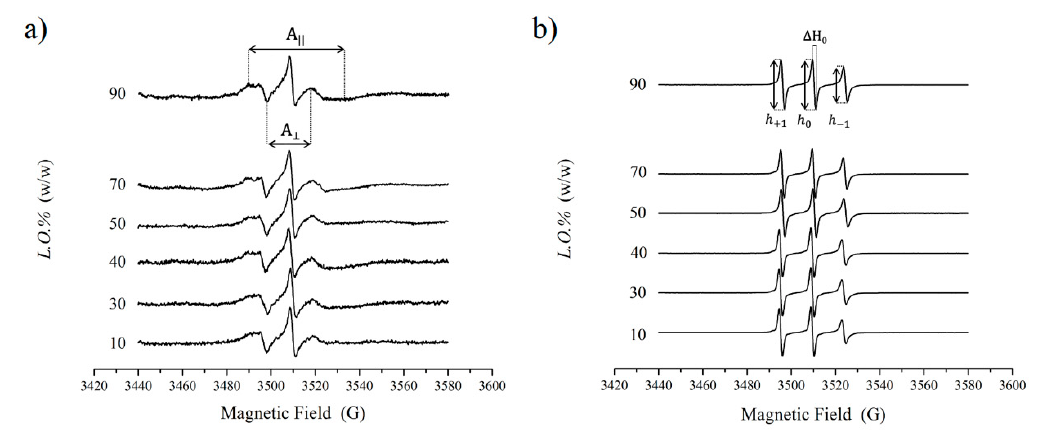
Figure 4. Electron paramagnetic resonance (EPR) spectra of 5-doxyl stearic acid (5-DSA) ( a ) and 16-doxyl stearic acid (16-DSA) ( b ) in water/L.O./(Tween80 + Span80) emulsions at 25 °C, recorded within 3 h from sample preparation. The total surfactant amount was fixed to 4% in weight with respect to the total sample amount and surfactant compositions was α Span80 = 0.4 in all samples. The oil content was progressively increased as indicated by the labels in the figures.